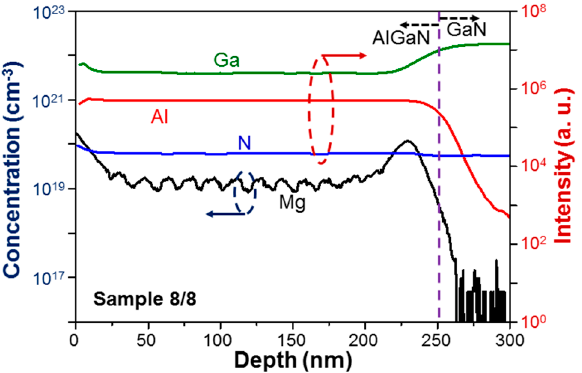
Figure 8. SIMS measurement results of sample 8/8 with the left ordinate for the absolute Mg con- centration and the right ordinate for the relative concentrations of Ga, Al, and N.